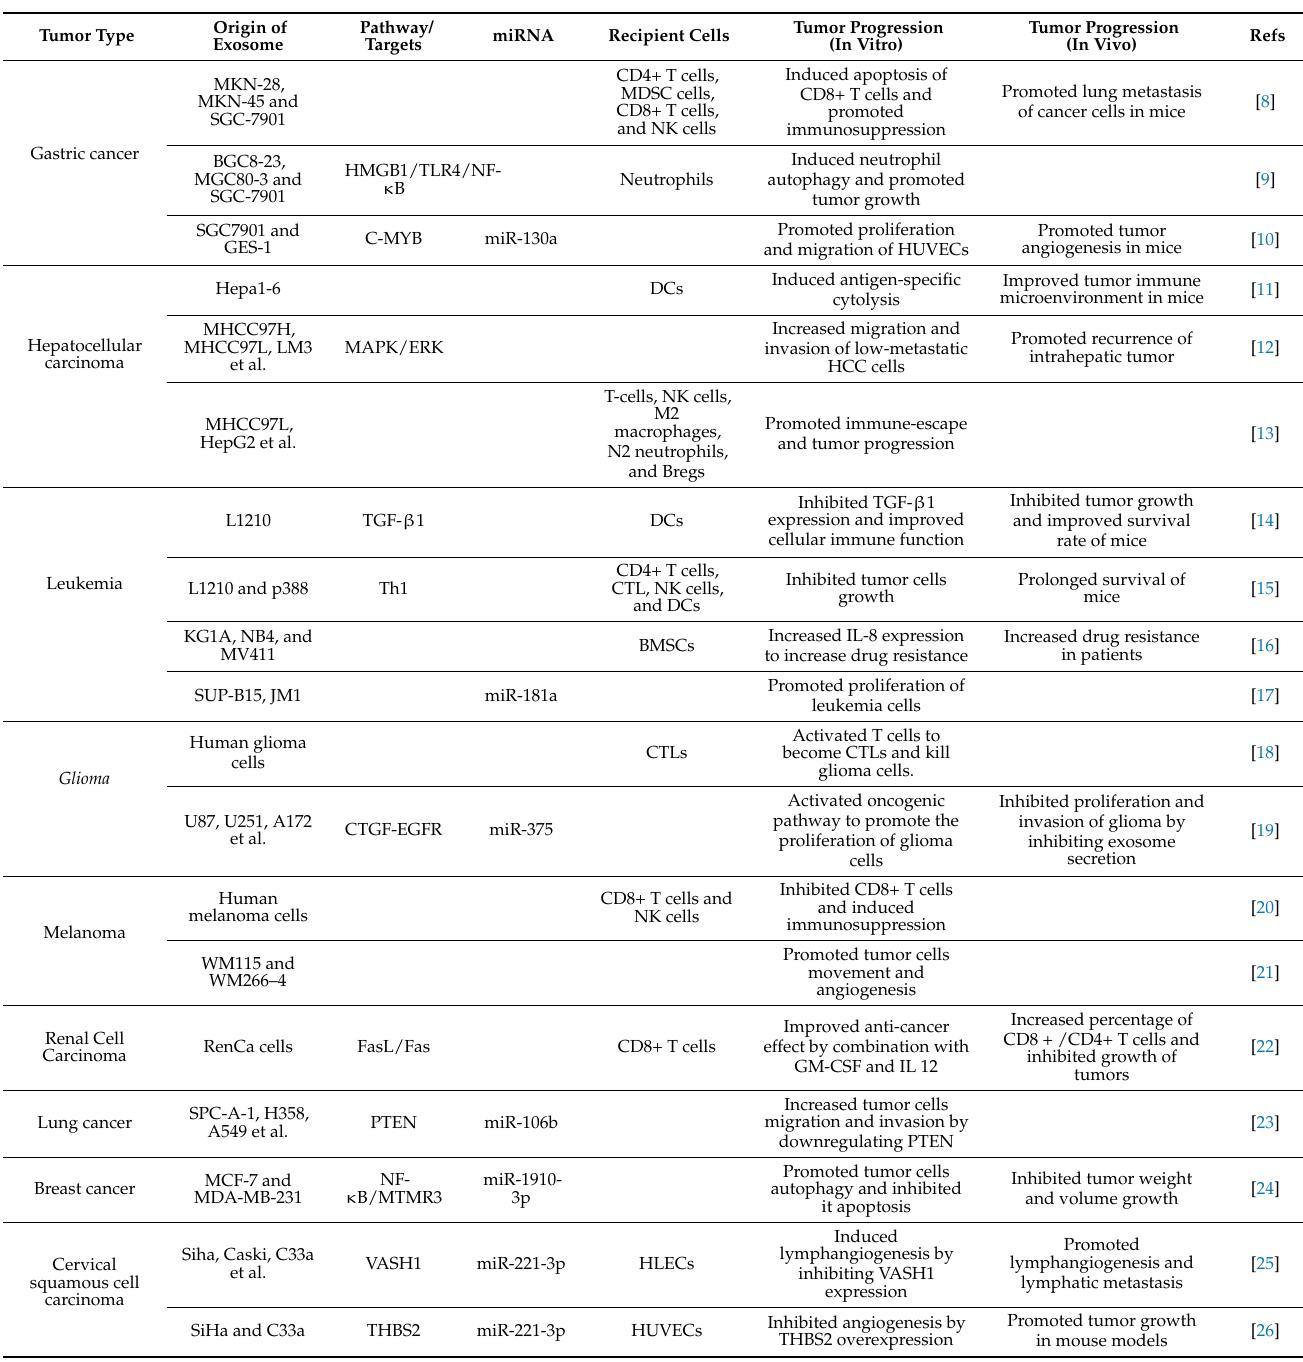
Table 1. The role of exosomes derived from different